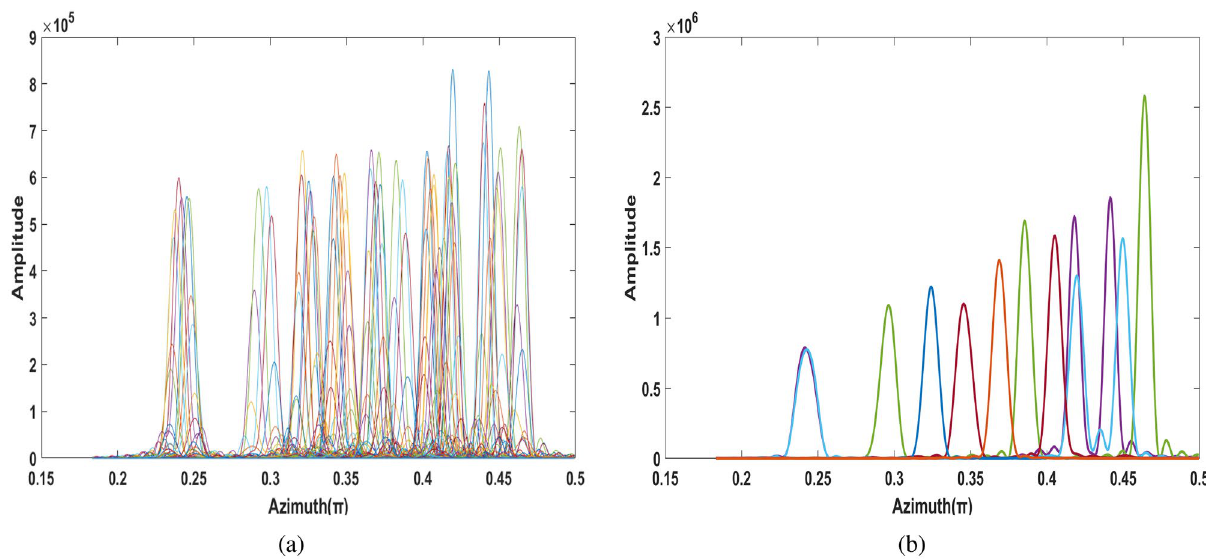
Figure 11. Azimuth profile. ( a ) Azimuth profile before compensation. ( b ) Compensated azimuth